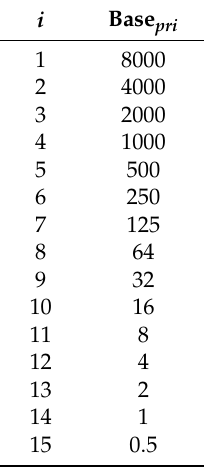
Table 1. Objective function reward per unit of slack for the base case scenario. For p = 1 to 120 and r = 1 to 20 as a function of increment i